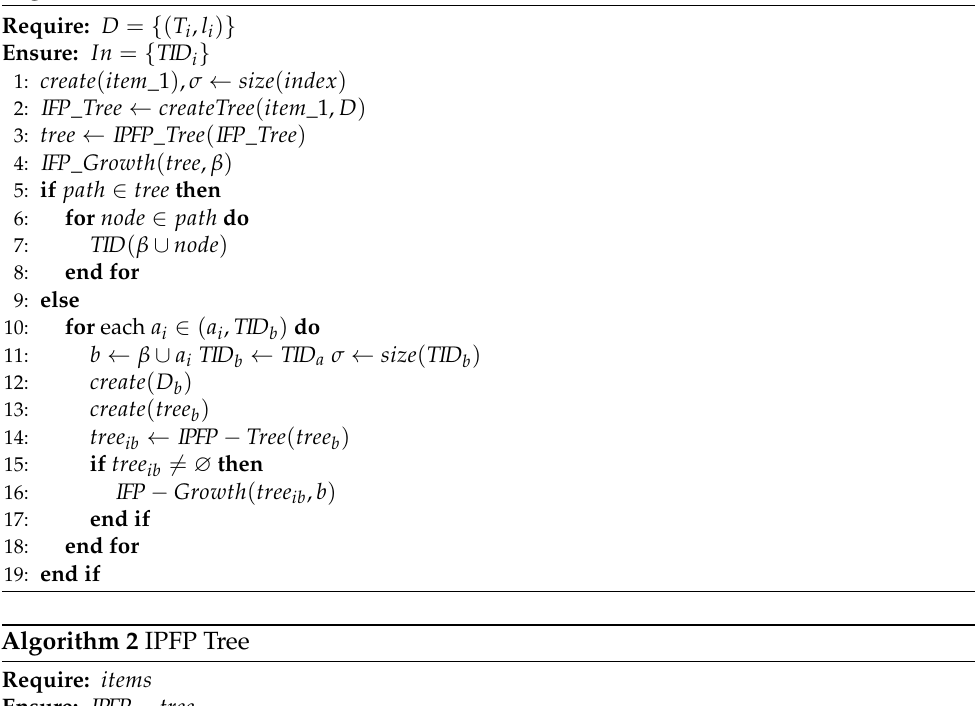
Algorithm 1 Index Tree